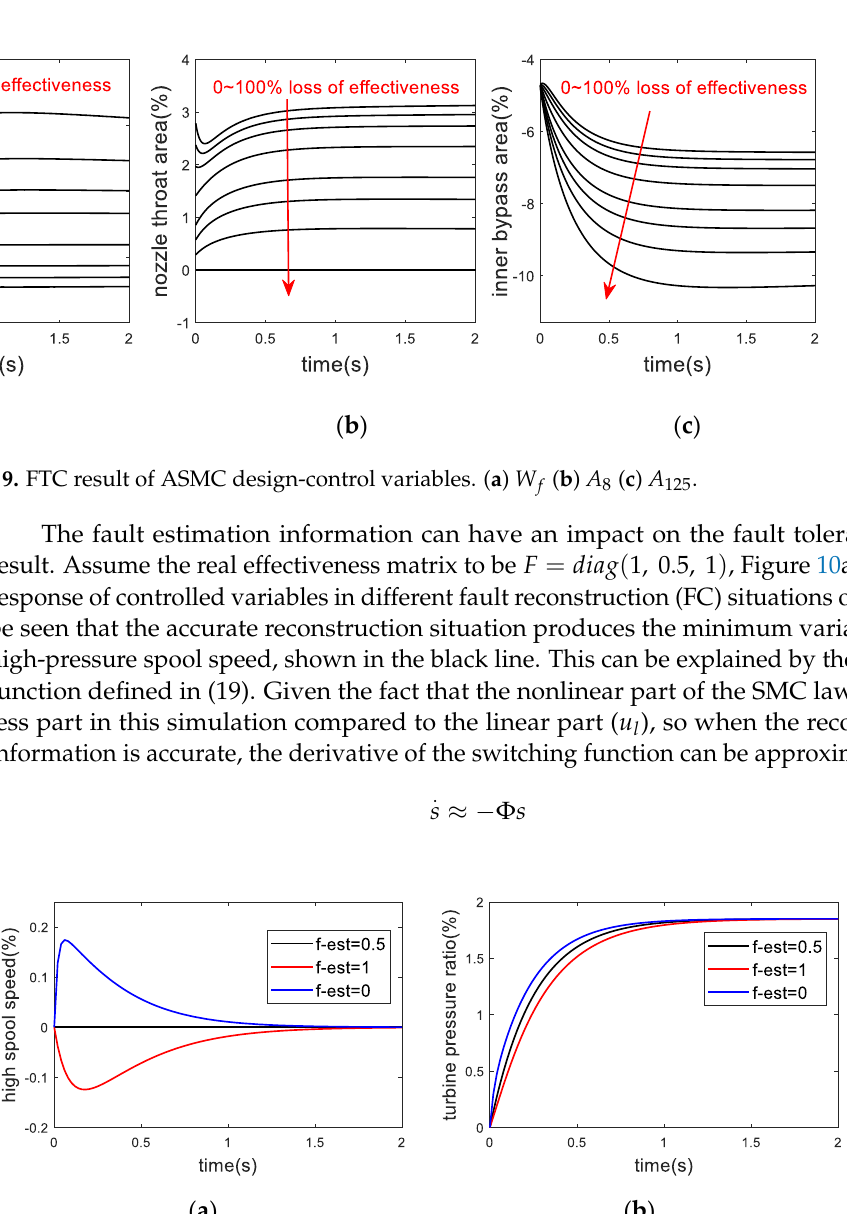
Figure 8. FTC result of adaptive SMC (ASMC) design-controlled variables. ( a )